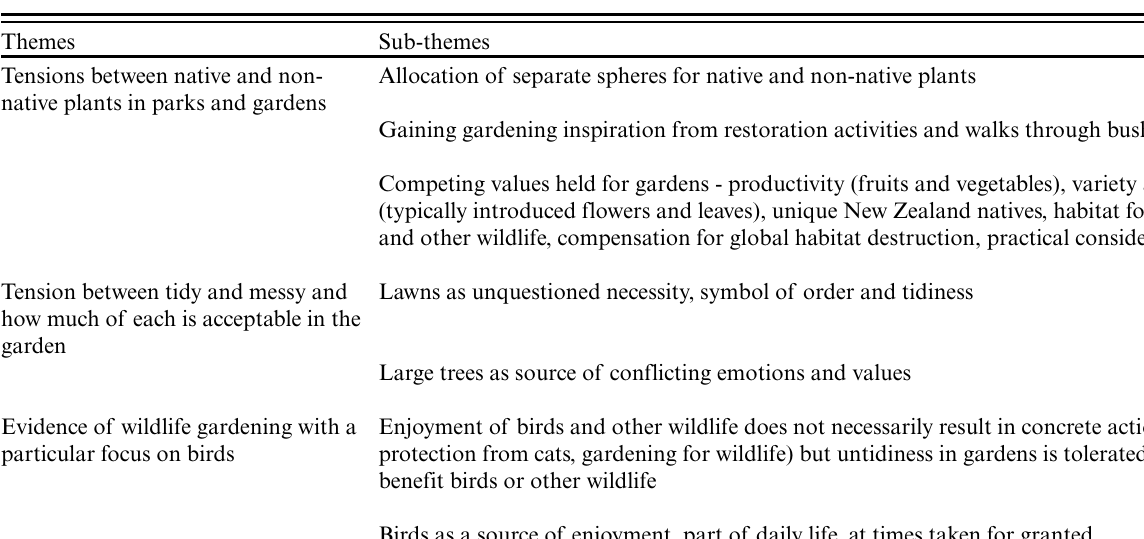
Table 1 . Overview of the main themes and sub-themes that emerged from the interviews. Themes